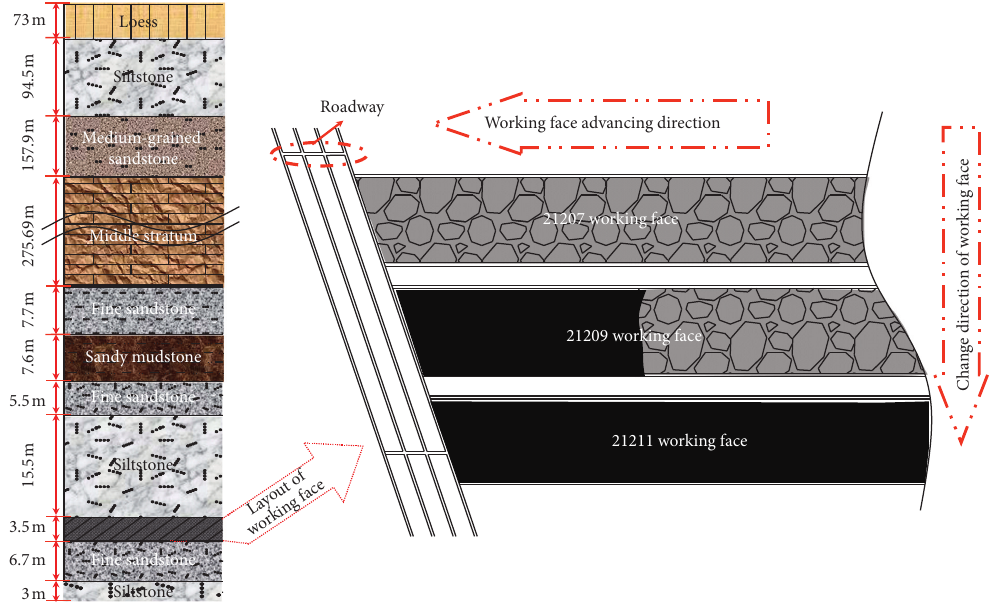
Figure 1: Occurrence characteristics of No. 21209 working face.